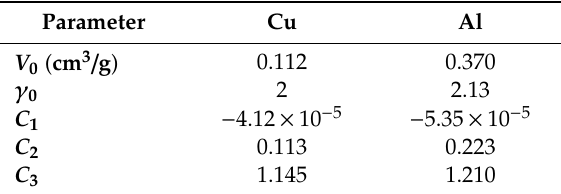
Table 9. Meadon-Burges parameters.